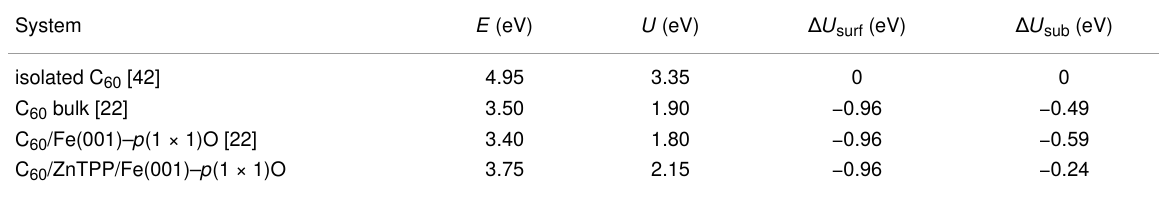
Table 1: Electronic coupling of C 60 with the Fe(001)– p (1 × 1)O and ZnTPP/Fe(001)– p (1 × 1)O substrates. E is the energy gap measured by electron- based spectroscopic techniques. U = E − γ is the on-site Coulomb energy, where γ = 1.6 eV is the HOMO–LUMO energy difference at equilibrium. Δ U surf and Δ U sub are variations of U with respect to the value of isolated C 60 due to the topmost layer and the substrate,